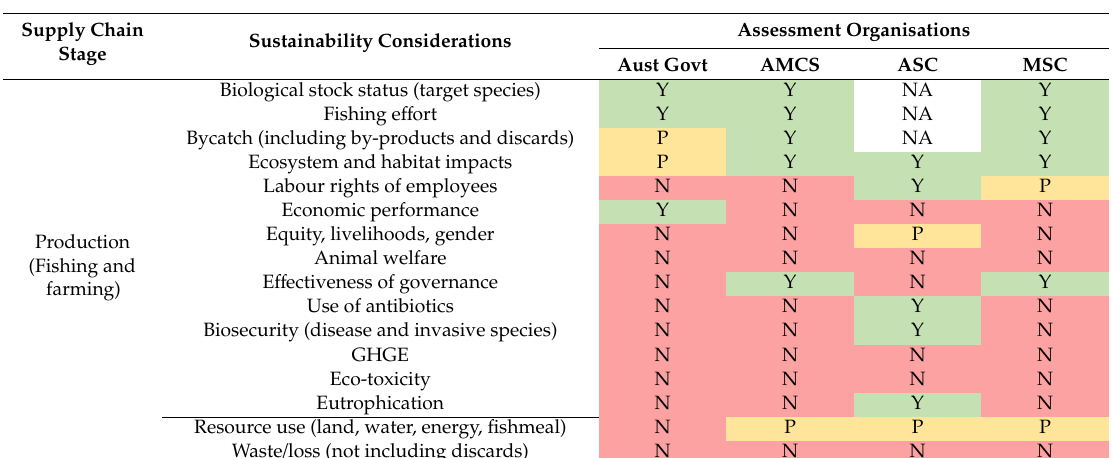
Table 1. Matrix comparing the di ff erent components of sustainability considered by di ff erent sustainability assessment frameworks used in